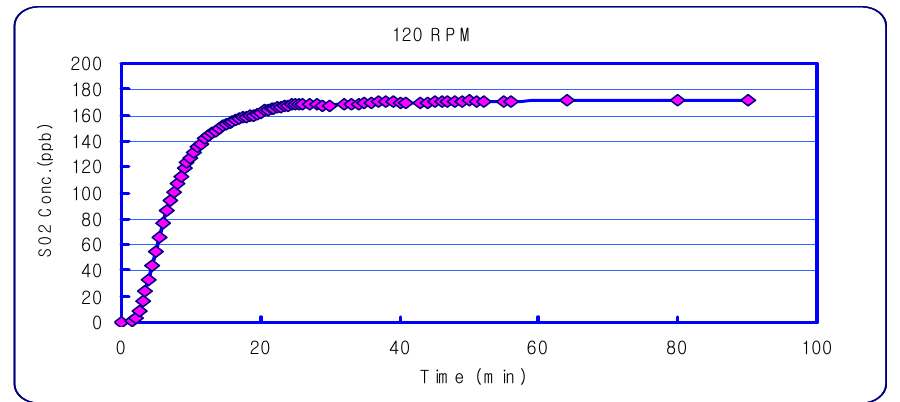
Figure 3. Concentration Variation inside the DFC with a 120 rpm